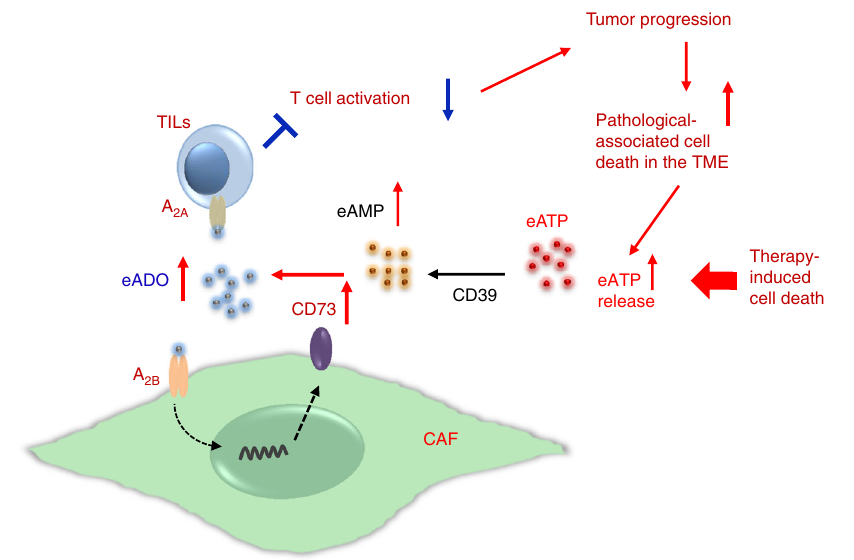
Fig. 9 A schematic illustration of the proposed mechanism of pathological and therapy-induced CAF-CD73 upregulation enforcing the immune checkpoint in the